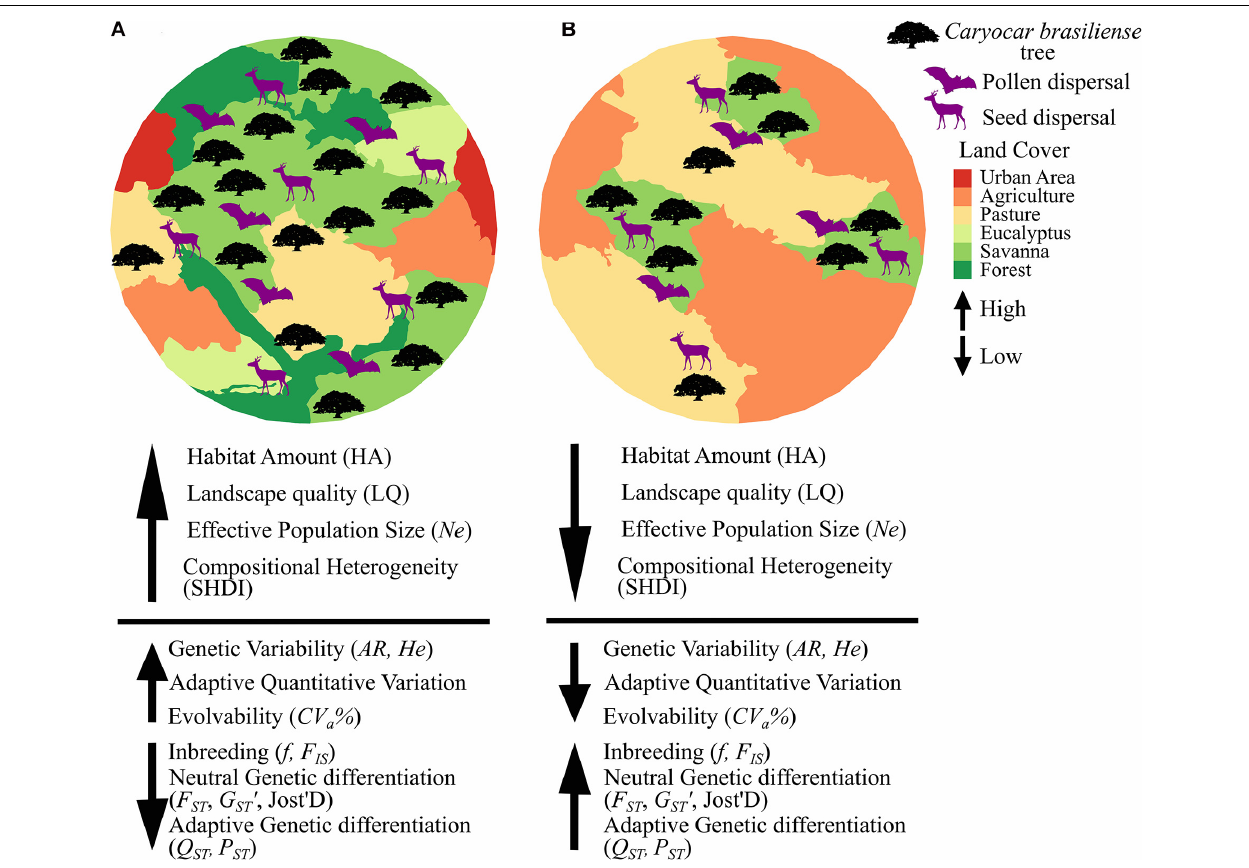
FIGURE 1 | Predictions of expected effects of landscape composition and configuration and effective population size on neutral and adaptive quantitative genetic variables in Caryocar brasiliense. Because landscape may affect pollen and seed dispersal and germination and establishment of C. brasiliense , we hypothesize that (A) landscapes with higher habitat cover (HA), compositional heterogeneity (SHDI), landscape quality (LQ) and effective population size ( Ne ) have higher neutral ( AR , He ) and quantitative genetic variability and evolvability ( CV a %), and lower genetic differentiation ( F ST , G ST ’, Jost’D, Q ST , P ST ) and inbreeding ( f, F IS ). On the other hand, (B) landscapes with lower HA, SHDI, LQ, Ne have lower neutral and quantitative genetic variability and evolvability, and higher genetic differentiation and